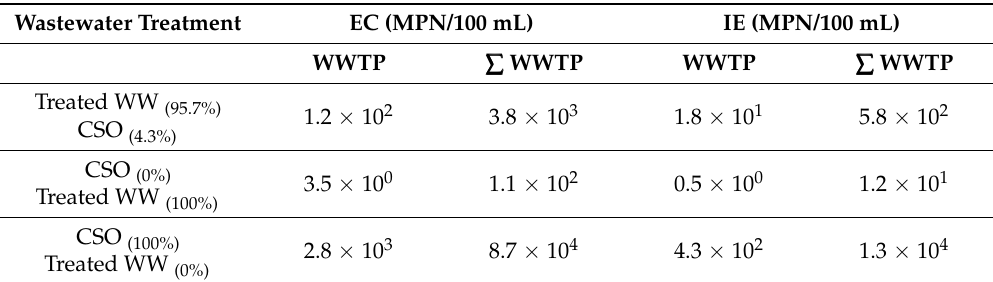
Table 7. Impact of 4.3% CSO, 100% treated wastewater and 100% untreated wastewater on the total course of the Mur River. Increase of EC and IE (MPN/100 mL) was calculated out of the median values of the mean discharge for the investigated WWTP and the sum of all WWTP ( ∑